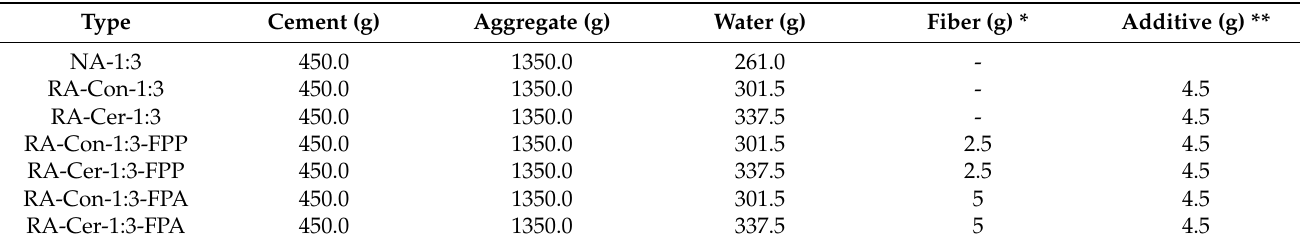
Table 6. Dosages used for the preparation of mortars.